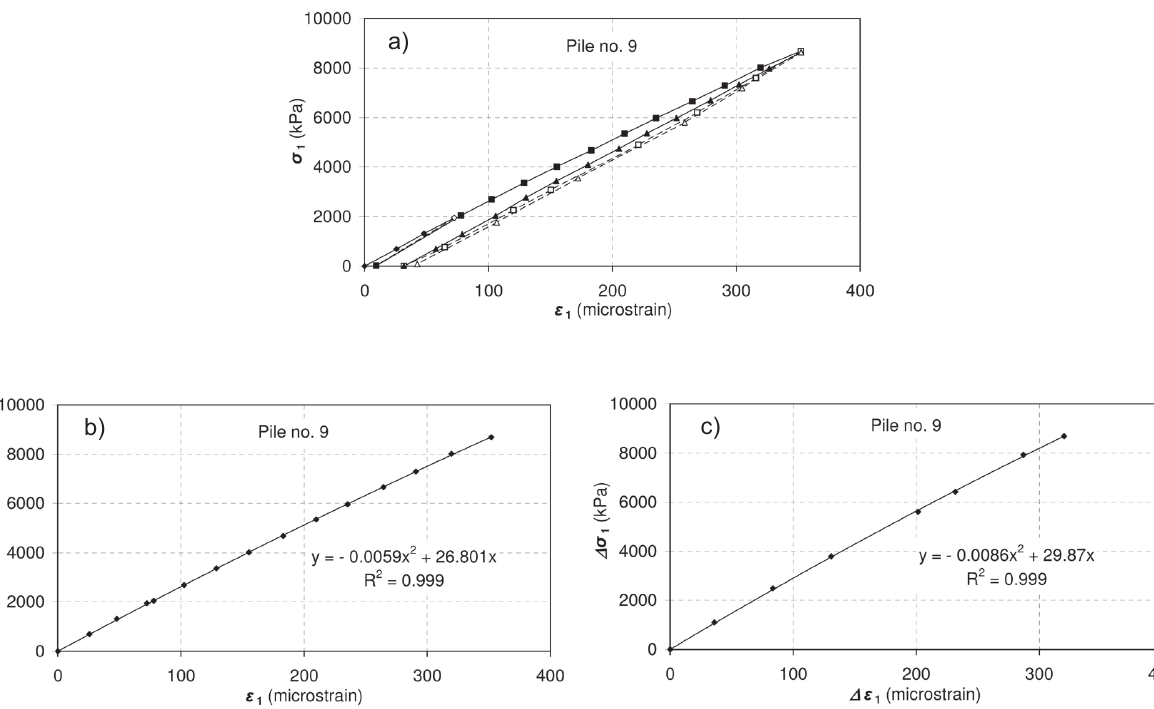
Figure 13: Stress–strain relation in the pile shaft determined in the first measuring section: a) general for load and unload; b) for load 1, described by a function and c) for unload 1, described by a